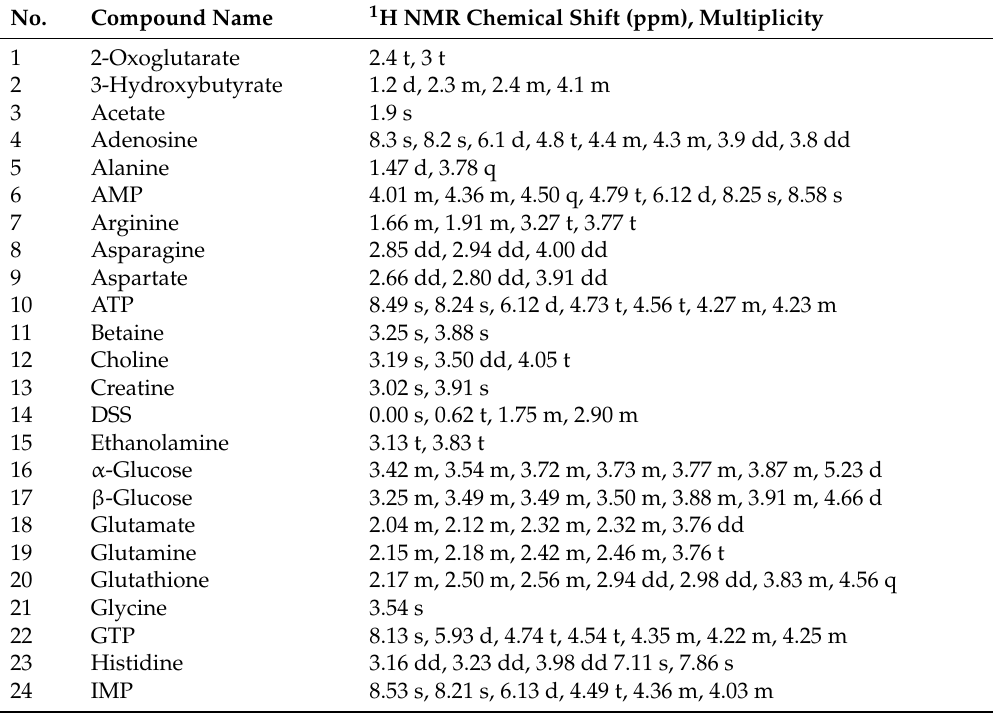
Figure 2. 1 H NMR spectra of the non-polar extract from avian liver. ( a ) Low frequency region. ( b ) High frequency region. Table 1. Compounds identified in the polar extract of avian liver tissue from NMR data: peak numbers (as shown in Figure 1a,b) and assigned chemical shifts (multiplicities).